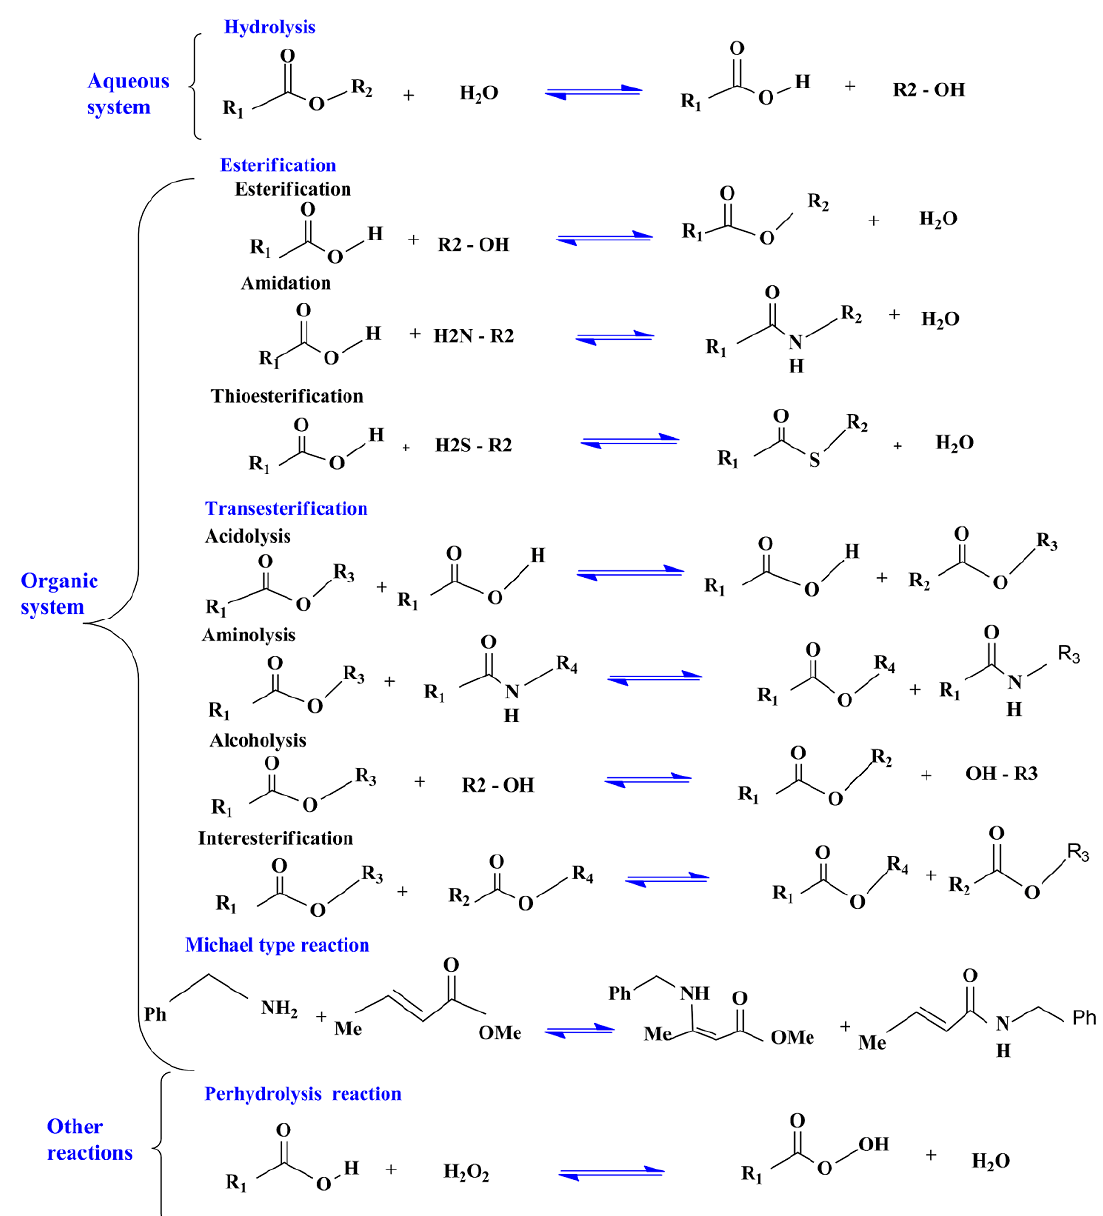
Figure 7. Reaction catalyzed by lipase in aqueous and organic systems [137].